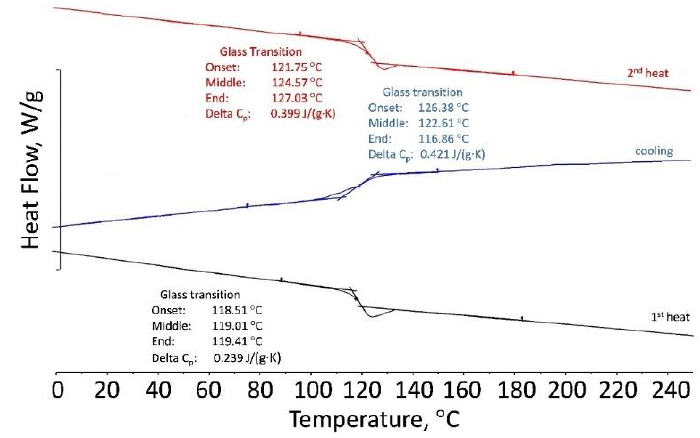
Figure 12. DSC curves of the 60Al 2 O 3 /40PLA composition.